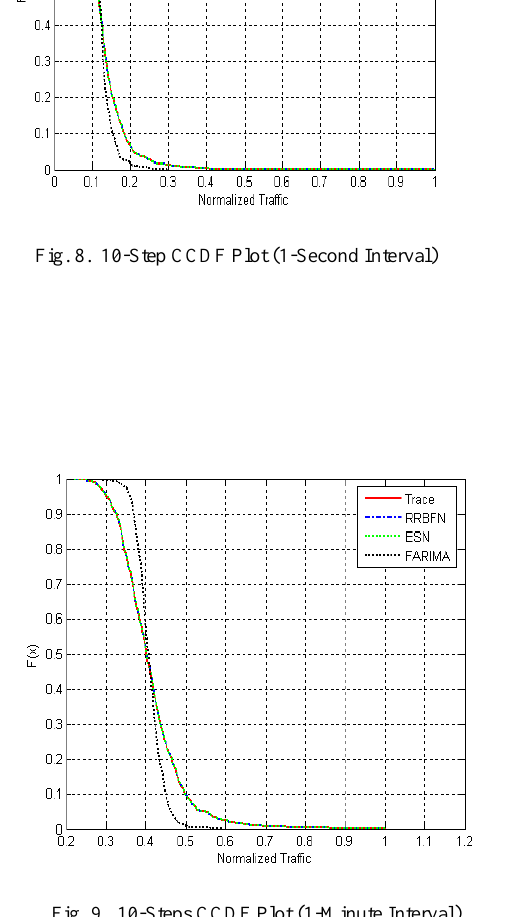
Fig. 9. 10-Steps CCDF Plot (1-Minute